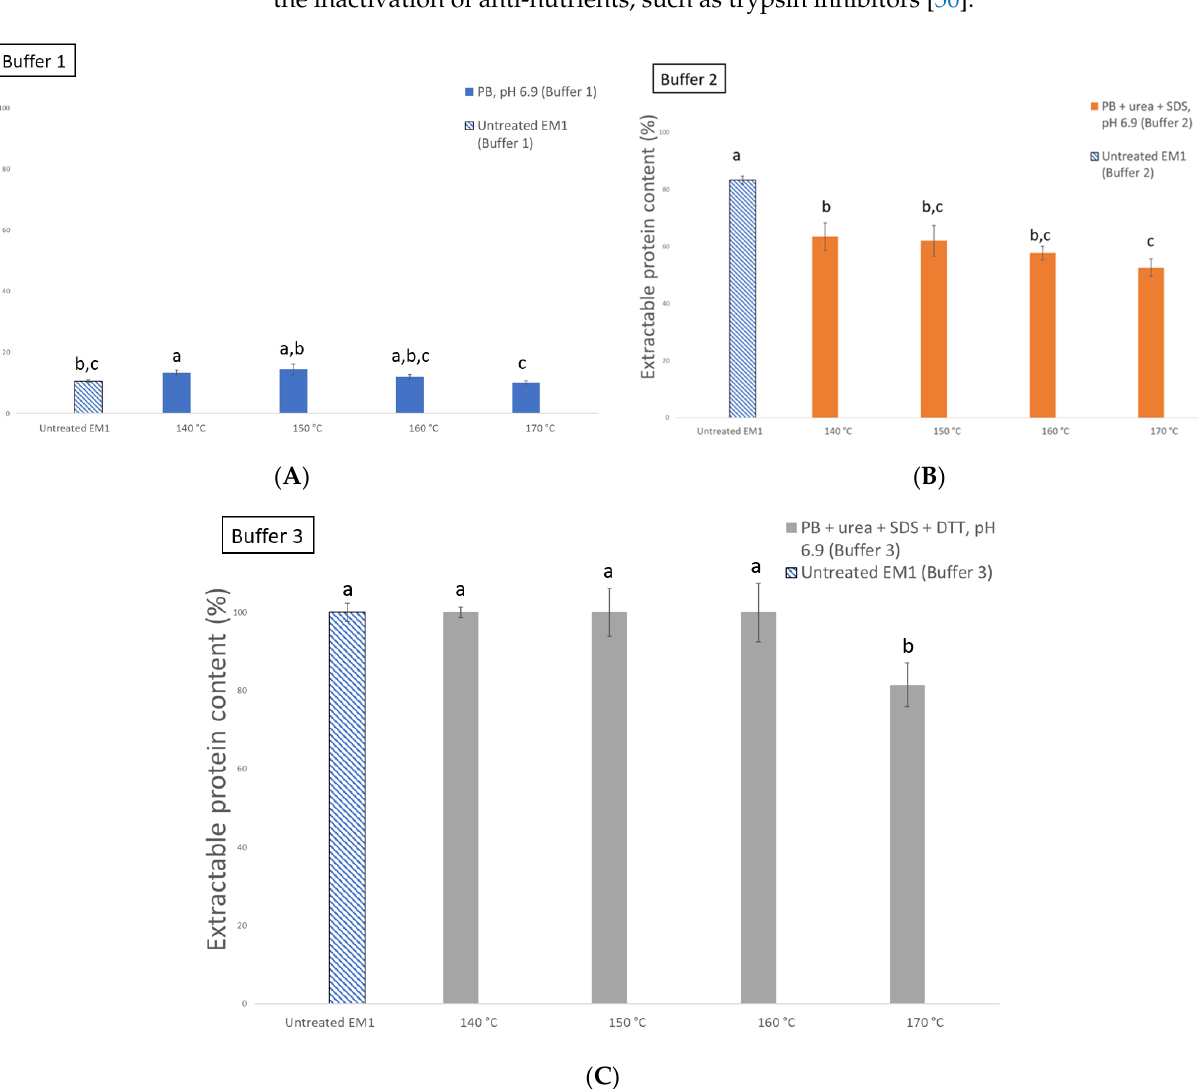
Figure 6. Change in the extractable protein content from the untreated destarched oat protein concentrate + pea protein isolate flour blend and the freeze-dried extrusion mixture 1 (EM1) at different extruder temperatures (140–170 °C): ( A ) after the disruption of electrostatic interactions (buffer 1); ( B ) non-covalent interactions consisting of electrostatic, mostly hydrophobic, and hydrogen bonds (buffer 2); ( C ) non-covalent and covalent interactions (buffer 3). Different letters (a, b, c) indicate significant differences ( p < 0.05) within the buffer group (buffer 1–buffer 3).